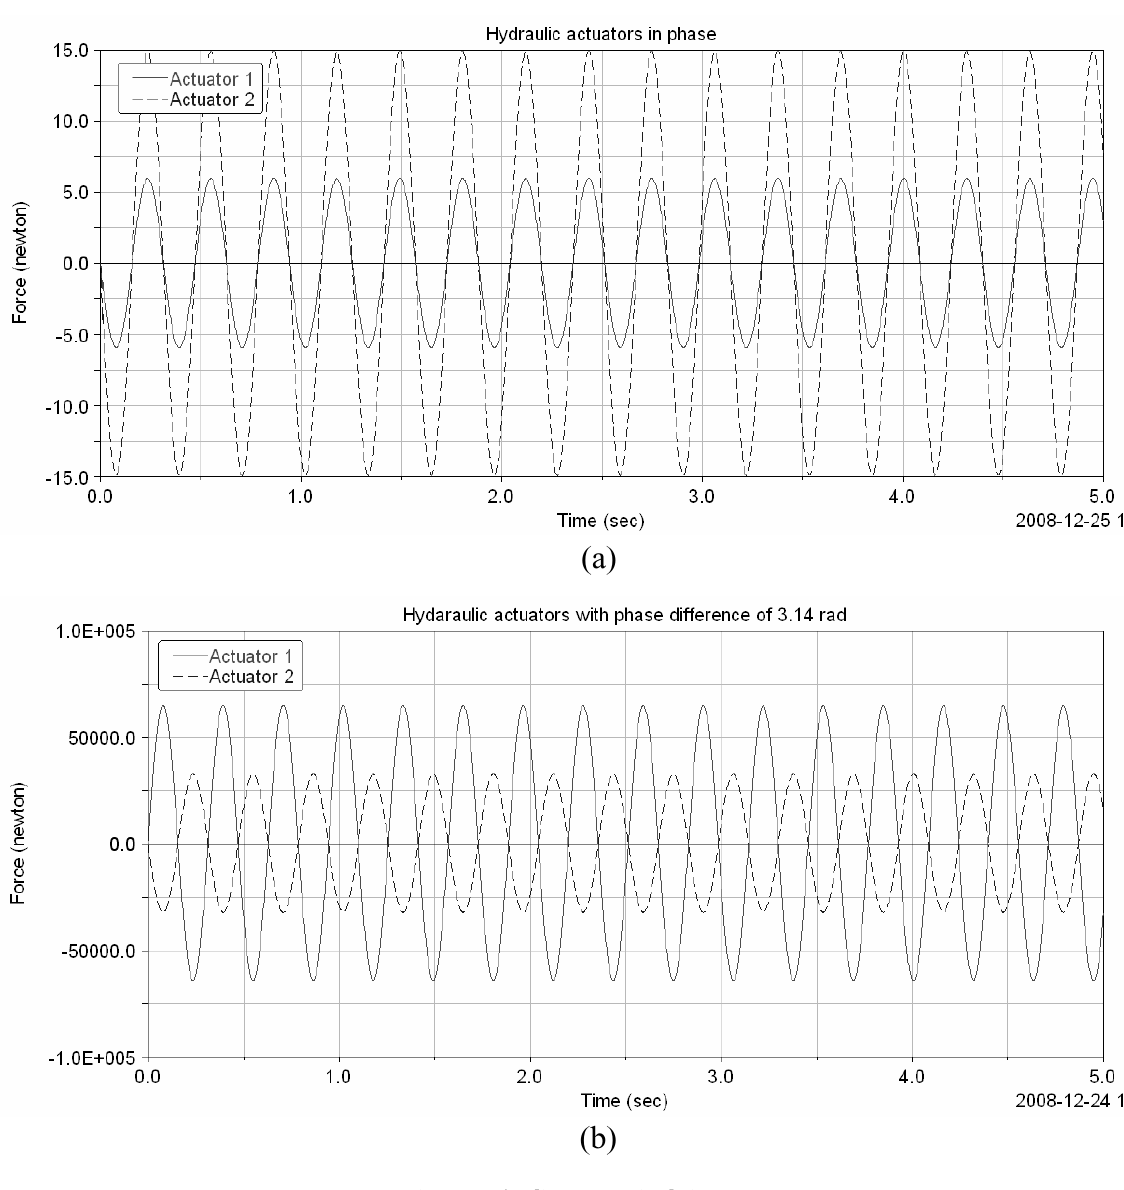
Fig. 10. Hydraulic actuator